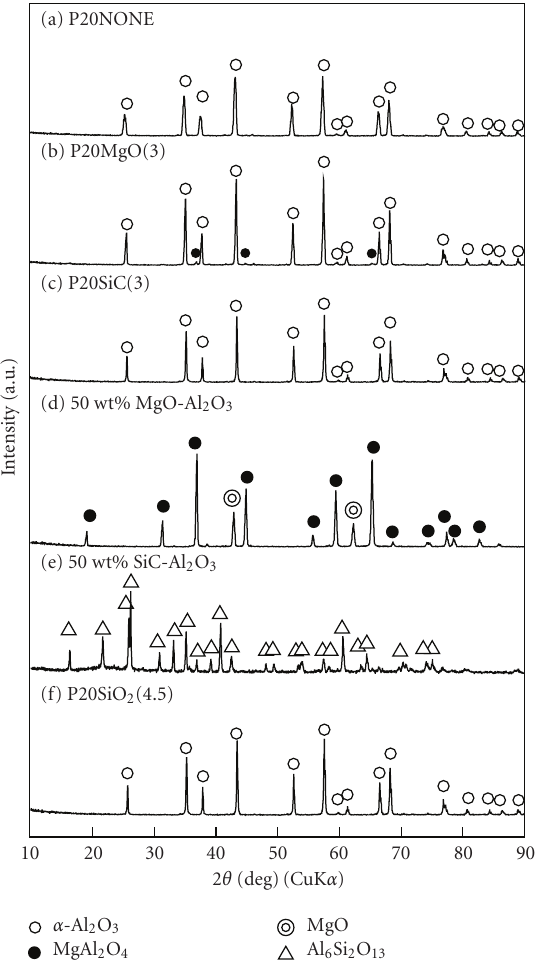
Figure 3: XRD patterns of (a) P20NONE, (b) P20MgO(3), (c) P20SiC(3), (d) 50 wt% MgO-Al 2 O 3 , (e) 50 wt% SiC-Al 2 O 3 and (f) P20SiO 2